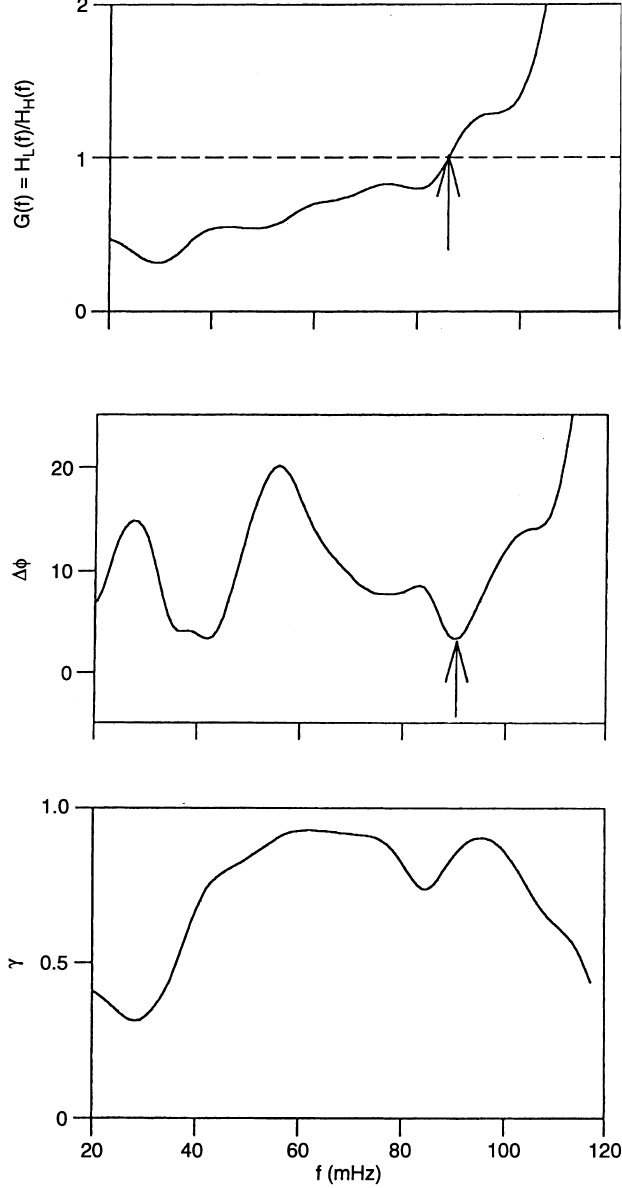
Fig. 11. The results of the quasi-gradient analysis of event 2 at near- conjugate stations MSR ( H ) and BSV ( L ) (from top to bottom ): spectra ratio G (cid:133) f (cid:134) (cid:136) H L (cid:133) f (cid:134) = H H (cid:133) f (cid:134) ; phase di(cid:128)erence D u (cid:133) f (cid:134) and coherency c (cid:133) f (cid:134) . The resonant frequency of a field line between the stations is marked by an